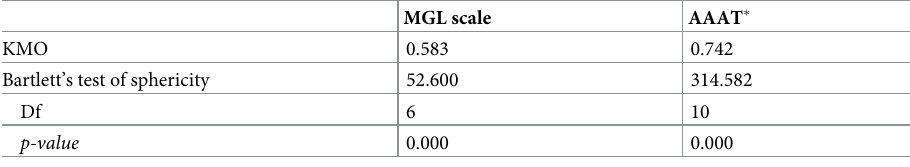
Table 6. Assessment of the data collection tool validity and reliability, N = 201.